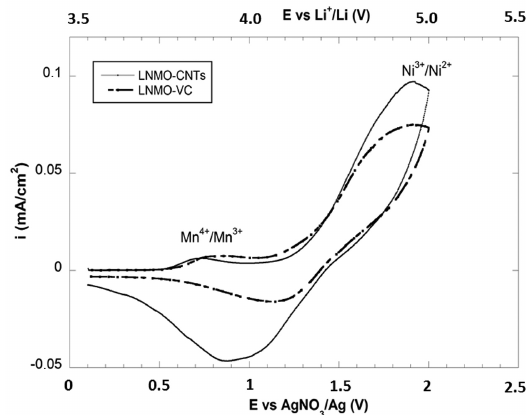
Figure 9. CV curves LMO/CNTs (2 wt%) nanocomposites (solid line) and LMO/VC (2 wt%) (dash dot line).